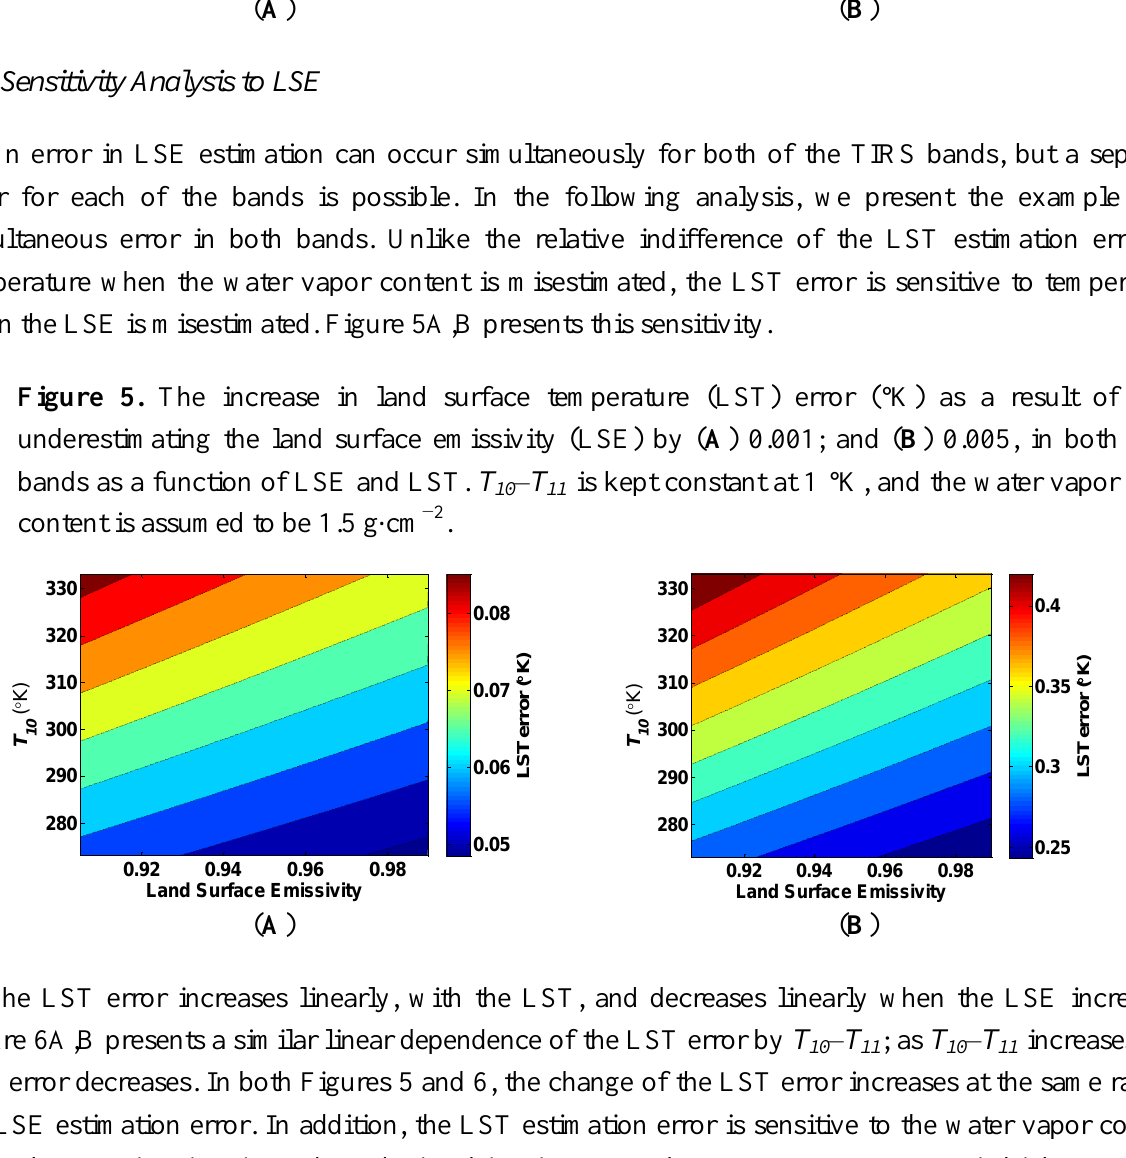
Figure 4. The increase in land surface temperature error (°K) as a result of underestimating the water vapor content in the atmospheric column by ( A ) 0.1 g · cm −2 ; and ( B ) 0.2 g · cm −2 , as a function of the land surface emissivity. T